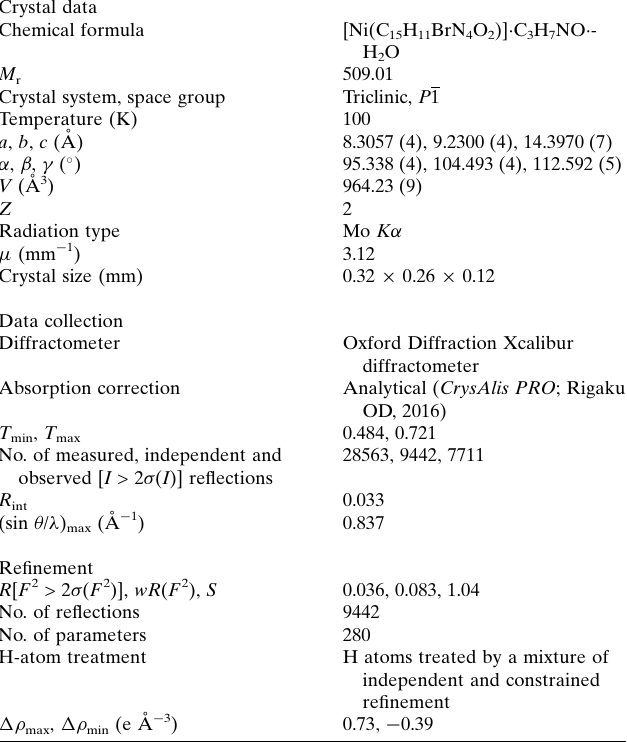
Table 3 Experimental details. Crystal data Chemical